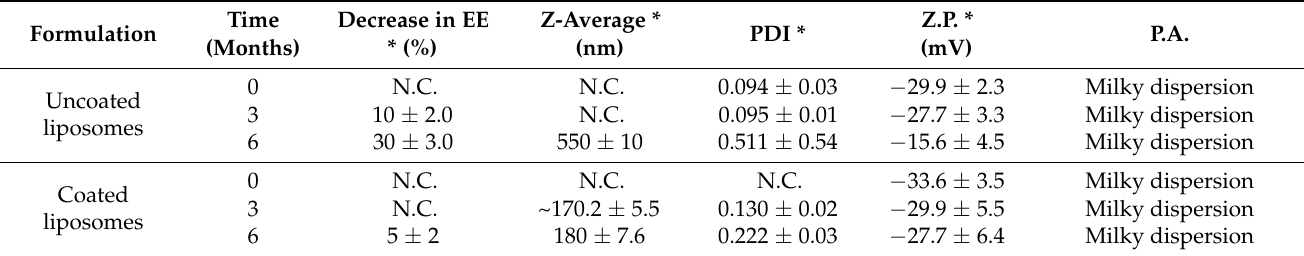
Table 6. Accelerated stability studies of coated and uncoated